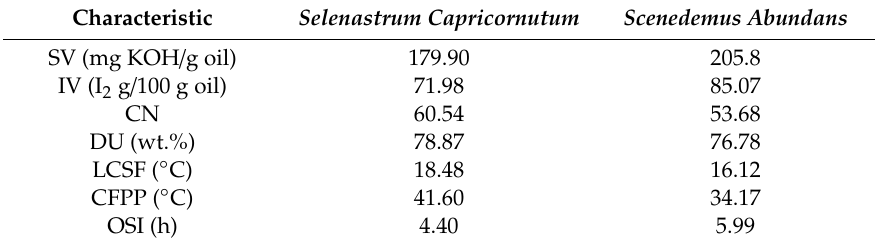
Figure 6. Comparison between saturated, monounsaturated, polyunsaturated fatty acids methyl esters of two microalgae: Slenastrum capricornutum and Scenedemus abundans [24]. Table 6. Predicted biodiesel properties of Slenastrum capricornutum (SC) and Scenedemus abundans (SA)